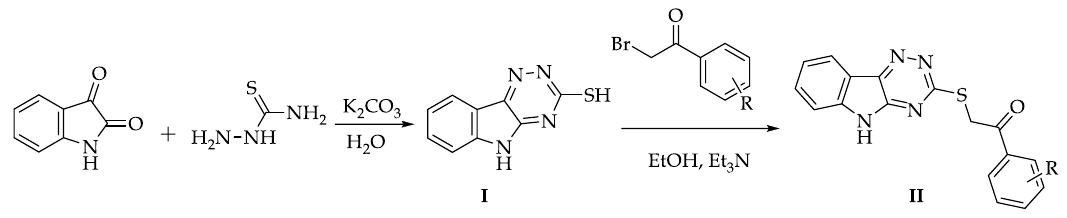
Scheme 1. Synthesis of triazinoindole derivatives.